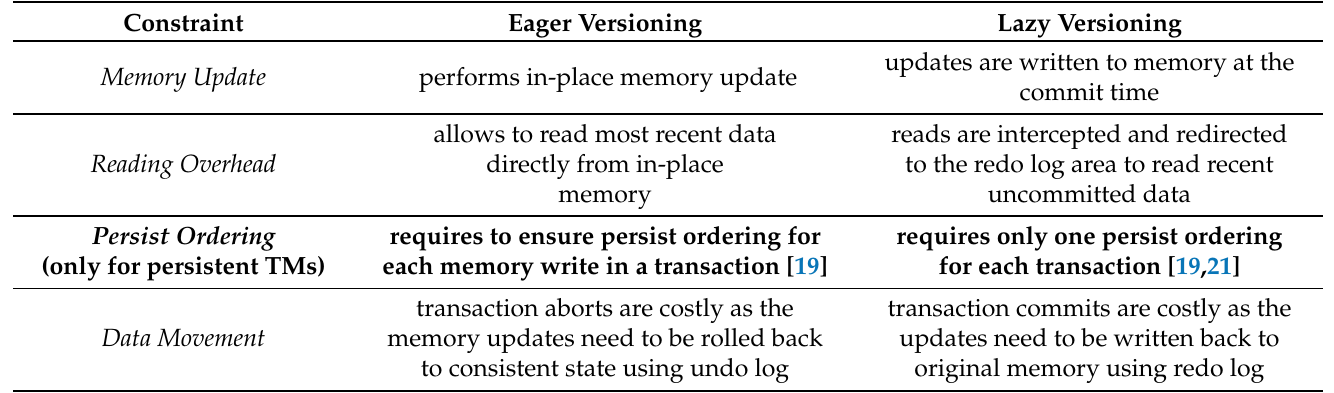
Table 1. A comparison of eager and lazy versioning in persistent and non-persistent TM systems (the row in bold text is only for persistent TM systems)